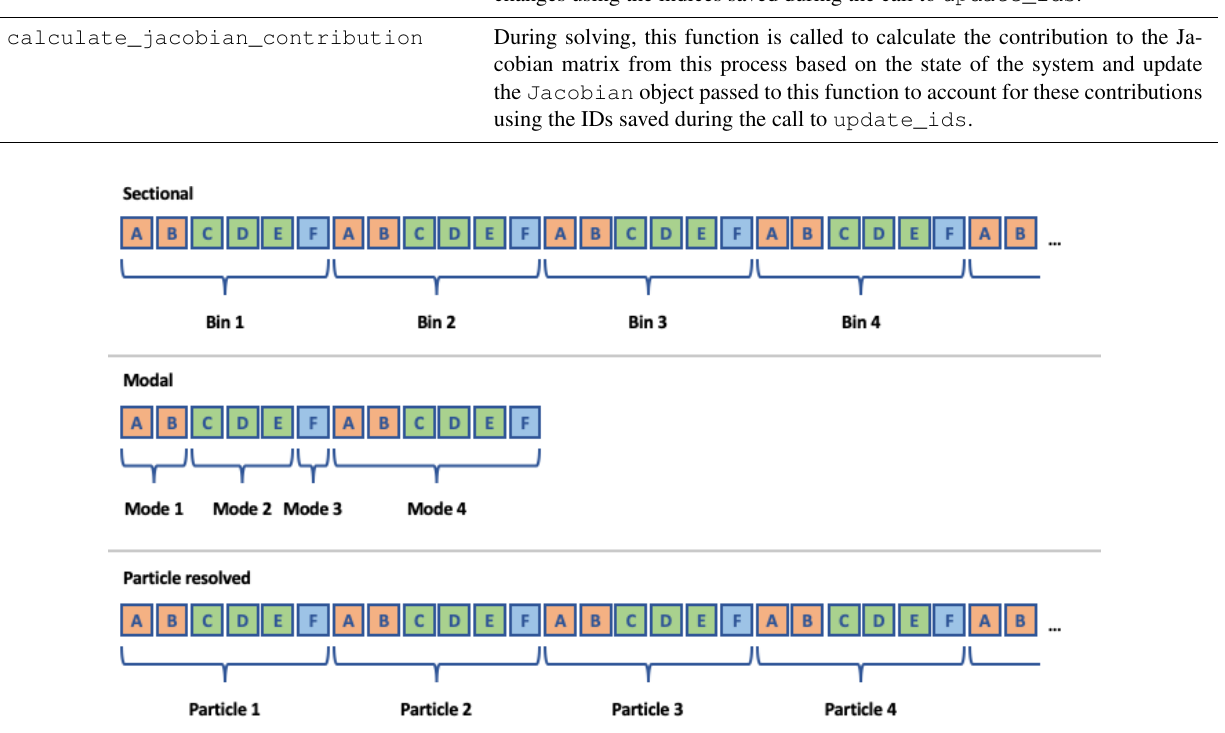
Figure 3. Common structures for aerosol state arrays in three different aerosol representations. Rows of boxes represent arrays used by a host model to describe the aerosol state during a simulation. Letters indicate unique condensed-phase chemical species concentrations. Colors indicate unique aerosol